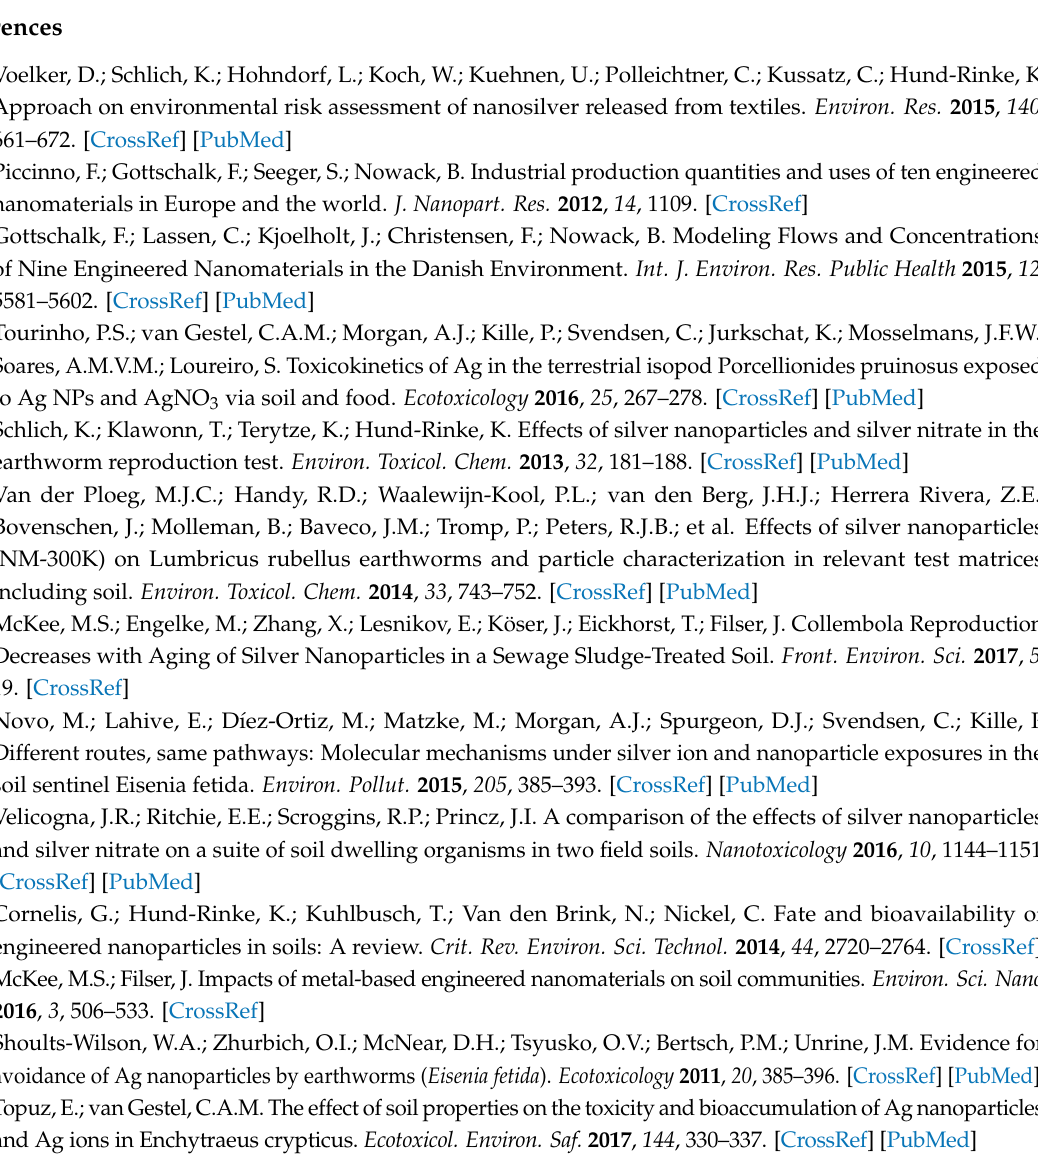
Figure S1: Reproduction in the controls with 40%, 50%, and 60% maximum water holding capacity